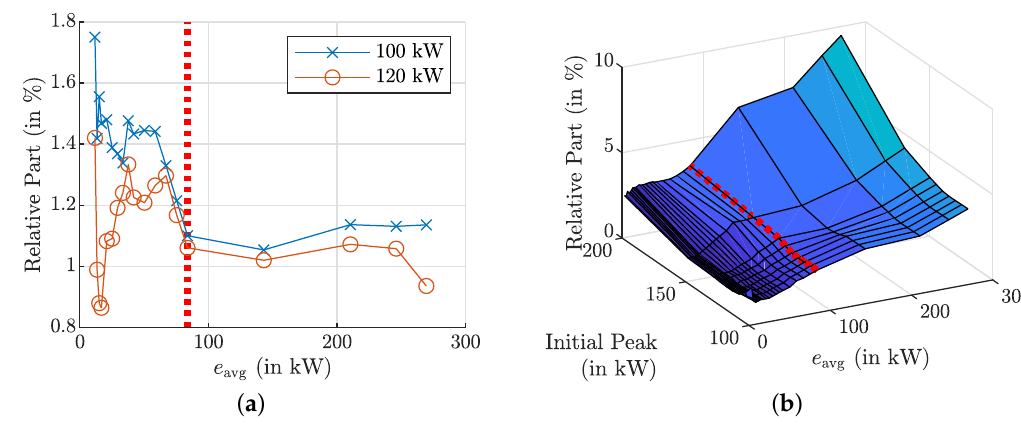
Figure 8. Parts of the additional monetary cost which are not caused by higher peaks. Again, the red lines indicate the real average prediction error. For the optimistic scenario ( a ), only simulations with initial peaks of 100kW or 120kW are shown, since, with higher initial peaks, generally, no new peaks occur. For lower initial peaks, they dominate, i.e, the non-peak costs are negligible ( ≤ 2%). For the pessimistic scenario ( b ), the part of additional non-peak costs increases with both higher e avg and initial peaks in P grid . However, in the most relevant part with initial peaks ≤ 120kW, they are still low ( ≤ 5%). ( a ) Optimistic Scenario; ( b ) Pessimistic